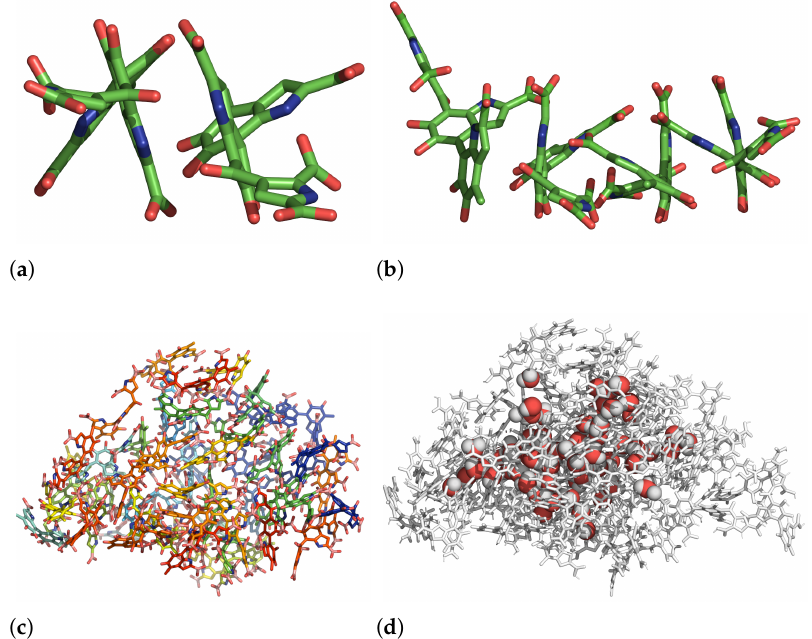
Figure 2. Size dependence of aggregation of uncharged DHICA eumelanin in an aqueous solution. For clarity, water molecules are not shown. ( a ) Two and ( b ) four uncharged DHICA molecules after 1073 ns and 983ns, respectively. Colours in ( a , b ): blue: nitrogen, red: oxygen, white: hydrogen, and green: carbon. ( c ) 50 uncharged eumelanins after 2050ns, carbon atoms are shown in rainbow to distinguish the residues. ( d ) Same as in ( c ), except the DHICA-eumelanins are shown in gray and water molecules within the aggregate as